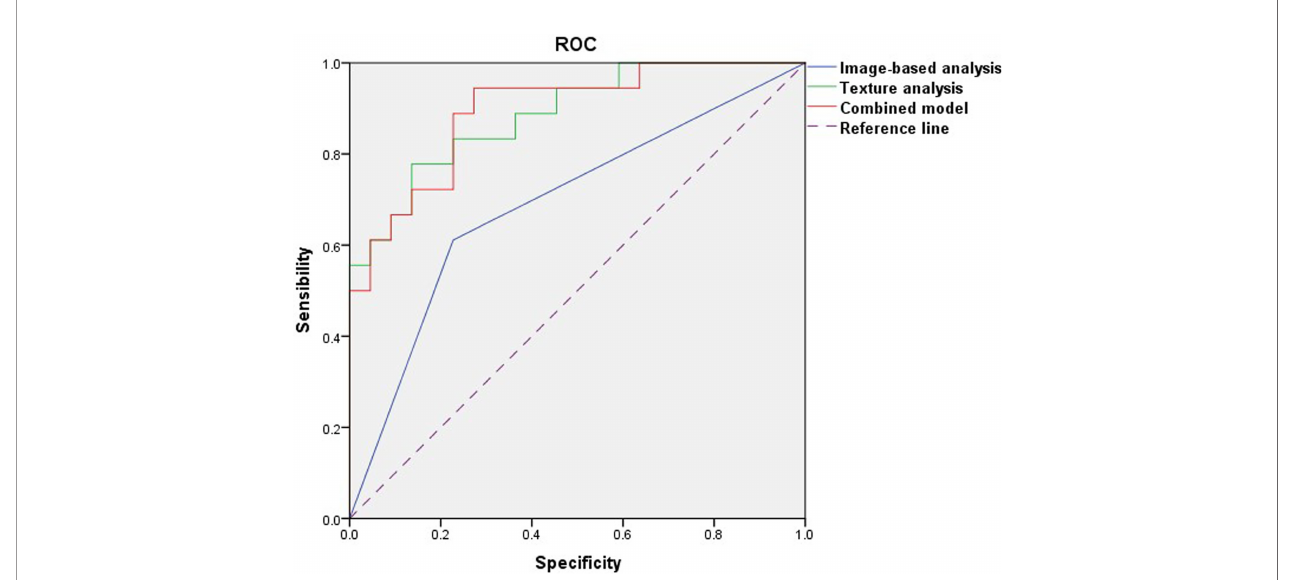
FIGURE 5 | Receiver operating characteristic curves of image-based analysis, TA, and the combined